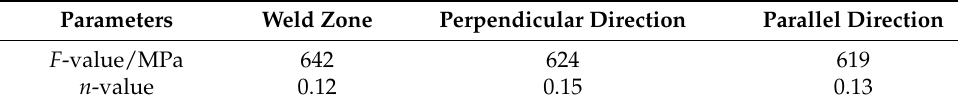
Table 7. F and n values of the tube obtained with the tensile